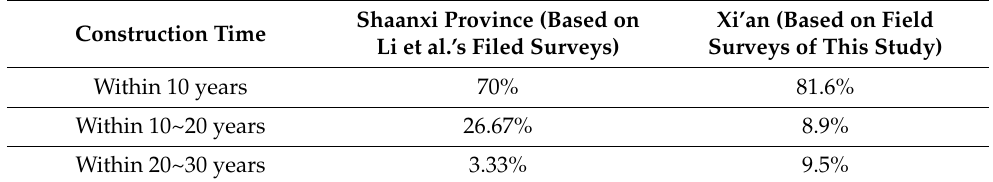
Figure 6. Typical rural house model: ( a ) 3D model; and ( b ) Configuration.